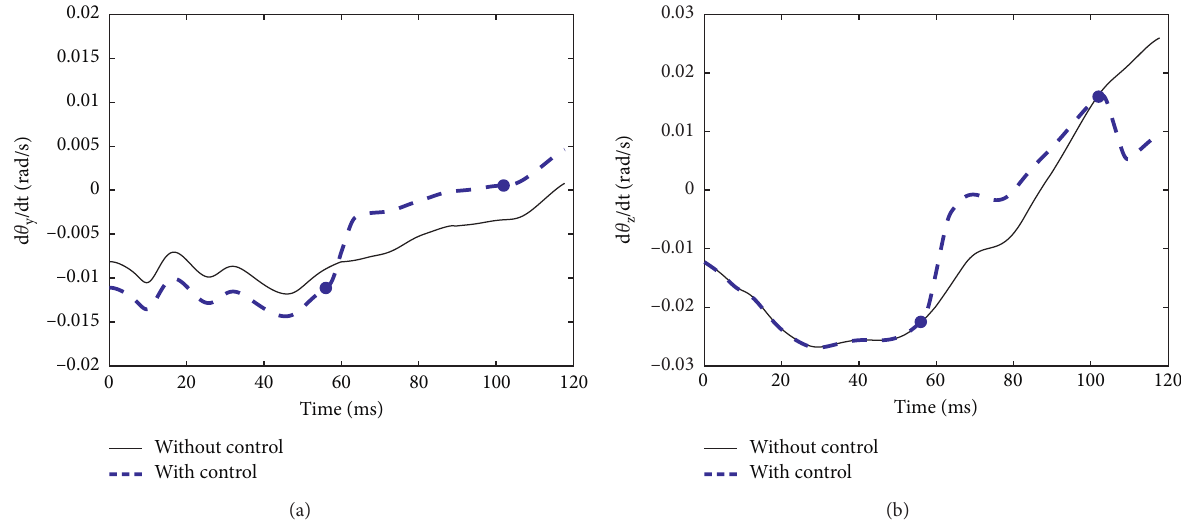
Figure 10: Simulated results of the elevation part in launching process for the 14th rocket under Condition 2: (a) the yawing angular velocity and (b) the pitching angular velocity. The blue dots indicate the action of the AAT.